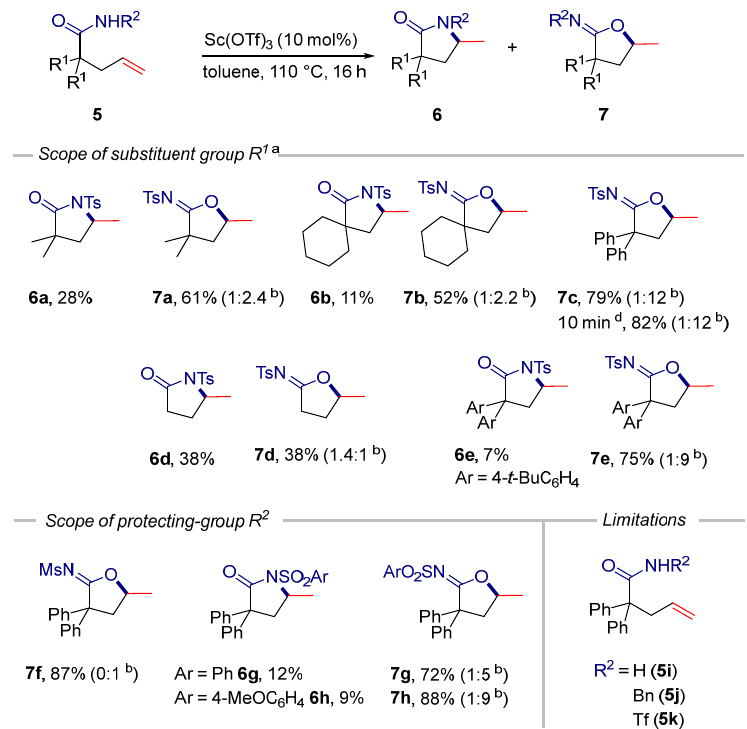
Figure 6. Sc(OTf) 3 -catalyzed cyclization of N -protected δ -alkenamides. c a isolated yields; b ratio of N - selective product vs. O -selective product determined by 1 H NMR on the crude reaction mixture; c all reactions run under thermal conditions unless otherwise stated; d run under microwave